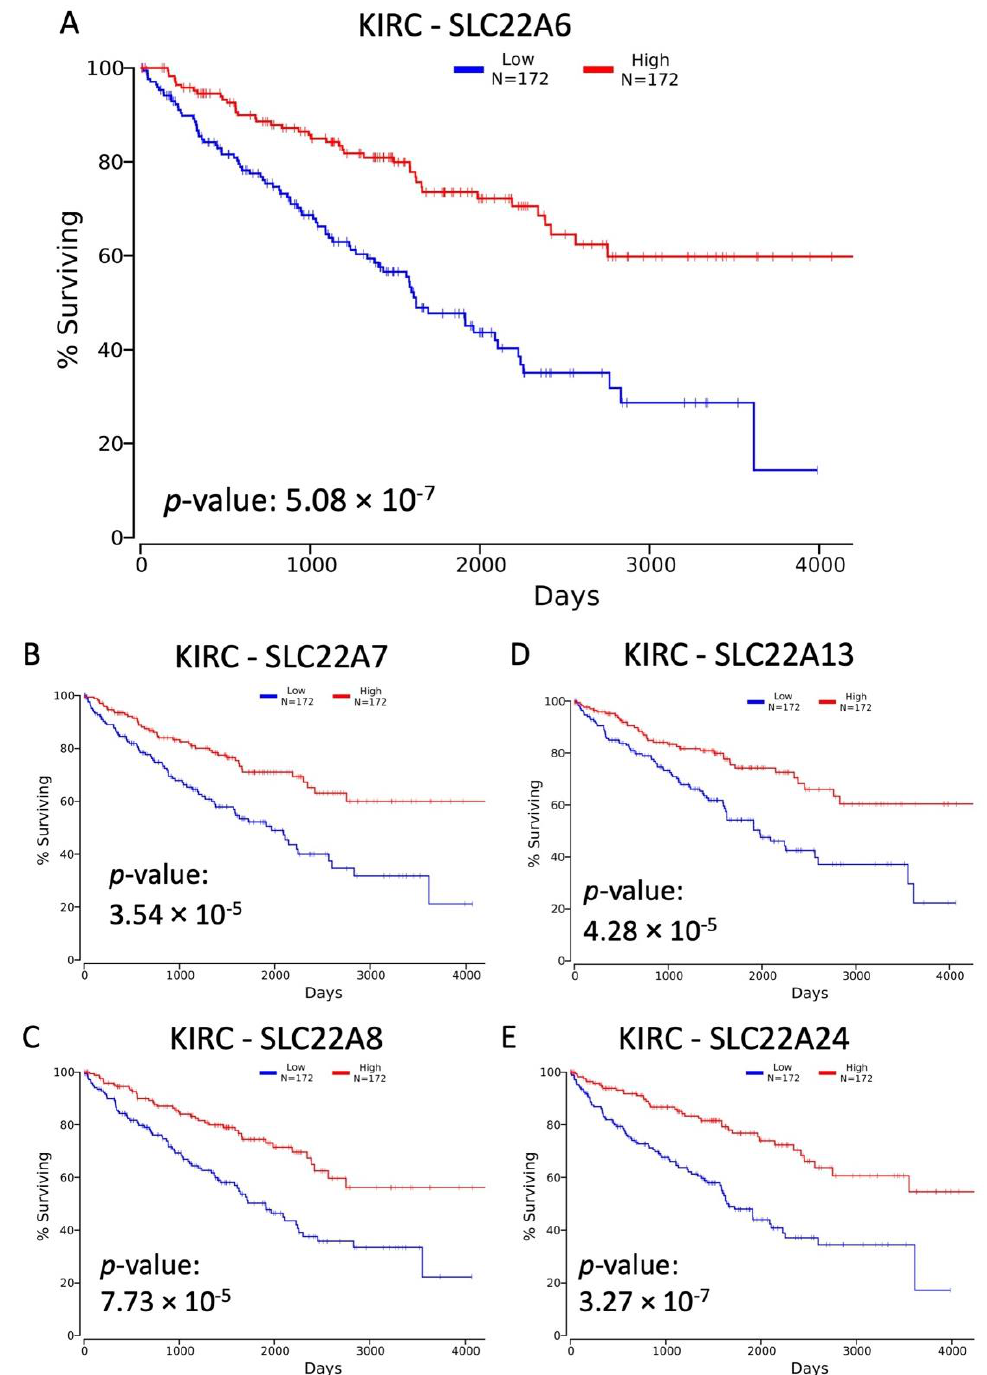
Figure 2. Kaplan–Meier plots for selected SLC22 genes in KIRC. Plot of the results of Kaplan–Meier survival analysis and logrank test showing the association of SLC22A6 ( A ), SLC22A7 ( B ), SLC22A8 ( C ), SLC22A13 ( D ), and SLC22A24 ( E ) expression and overall survival (in days) in KIRC. High expression is defined as the top tercile (n = 172) of patient tumor values and low expression represents the bottom tercile. The p -value of the logrank test is significant at less than 0.05.